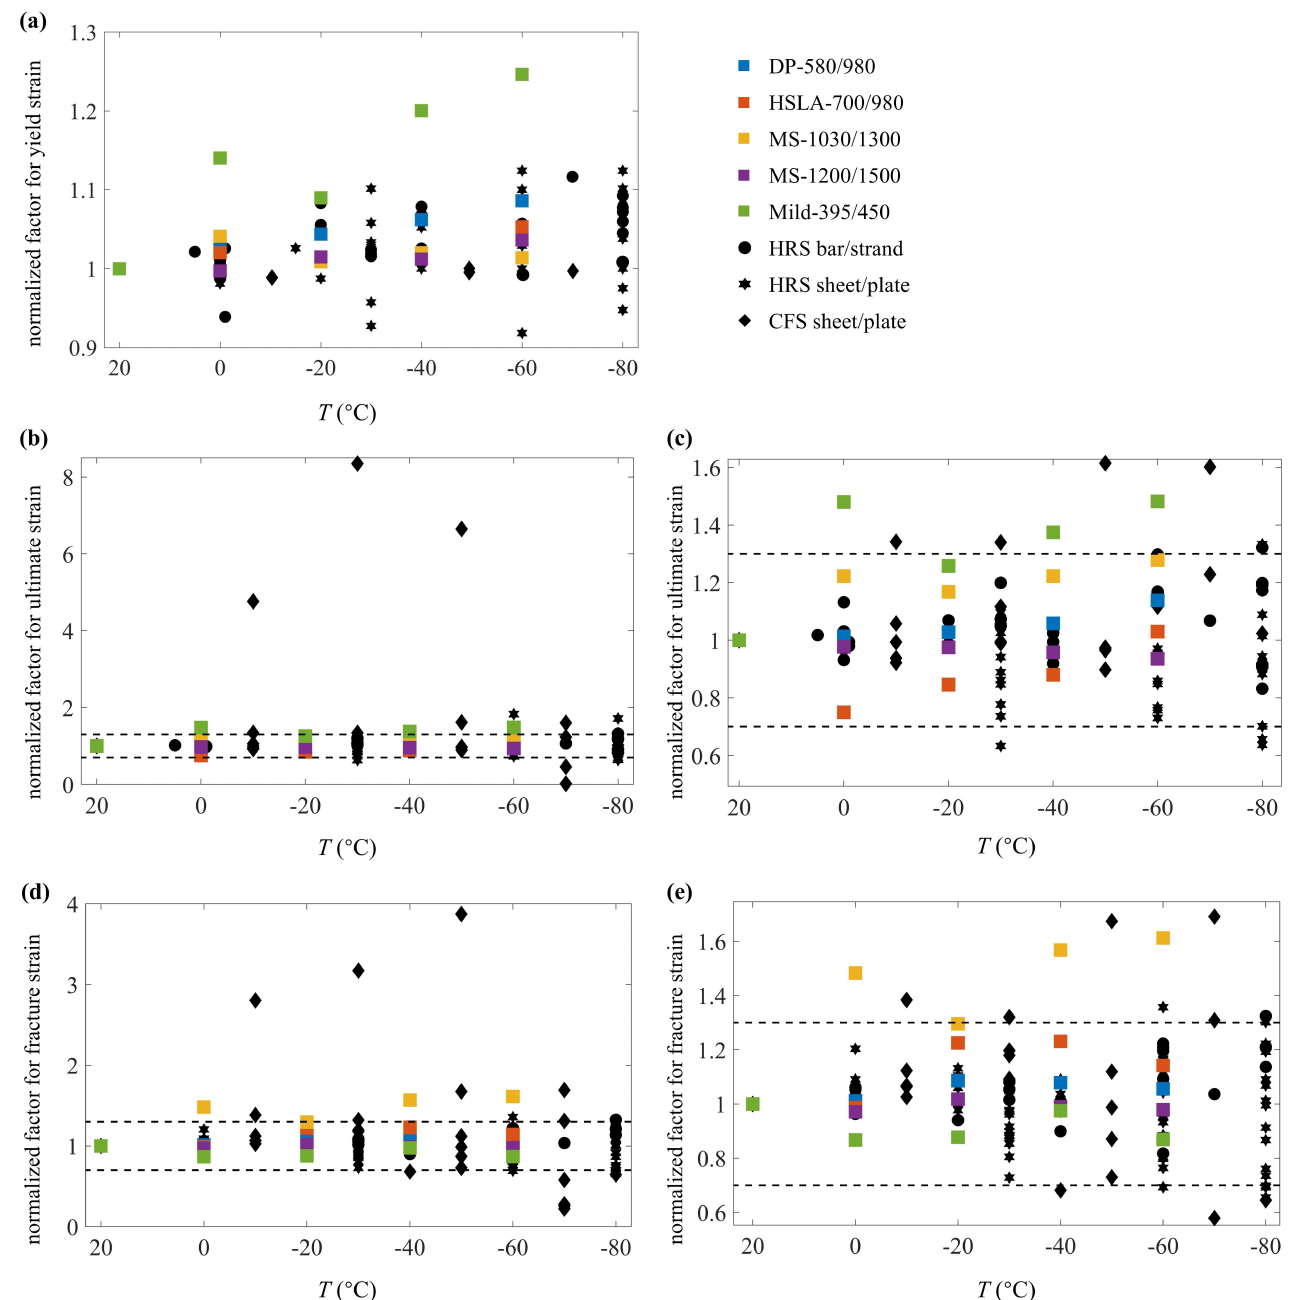
Figure 11. Normalized factors of ( a ) yield strain, ( b ) ultimate strain, and ( d ) fracture strain for AHSS, HSLA-700/980, Mild-395/450, and data from published experiments. Subplot ( c ) is a magnification of subplot ( b ) at a normalized factor of 1. Subplot ( e ) is a magnification of subplot ( d ) at a normalized factor of 1. The dashed lines represent an increase/decrease of 30% compared with